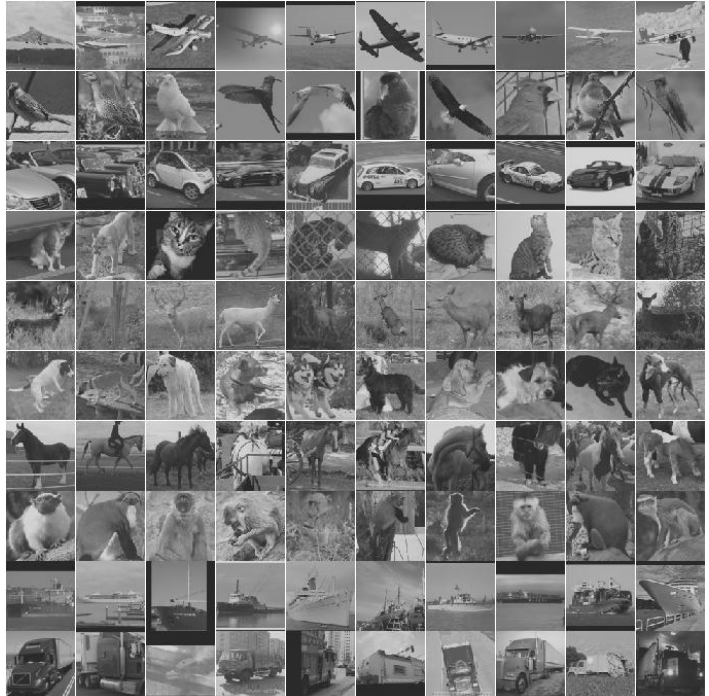
Figure 6. A sample of the STL-10 dataset [22] representing images for all ten classes in